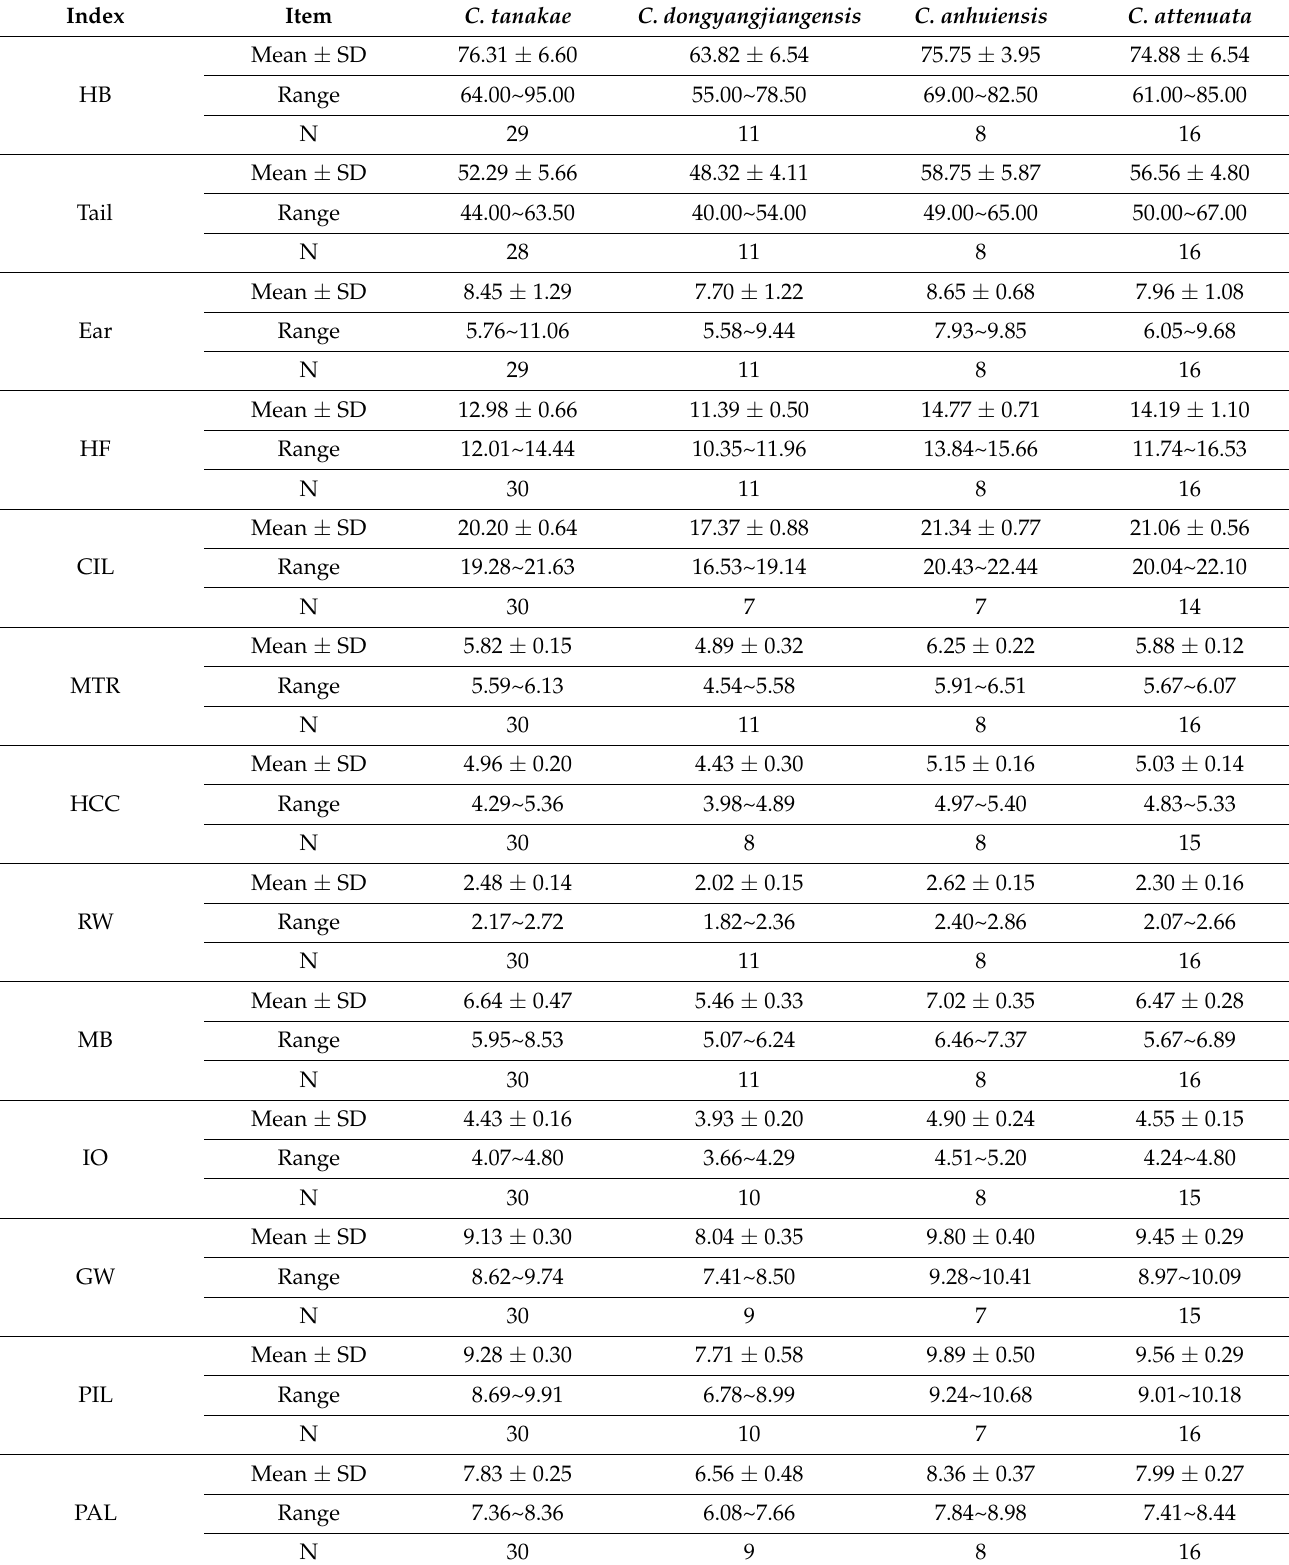
Table 2. External and skull measurement indices of C. attenuata species